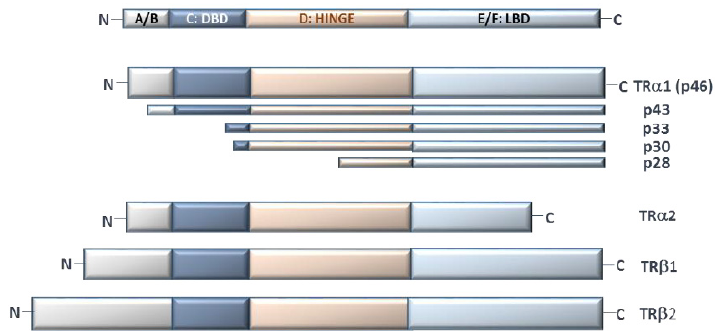
Figure 2. Schematic representation of the main TH isoforms. A/B: N-terminal domain, C: DNA binding domain (DBD), D: hinge region, E/F: ligand binding domain (LBD). binding domain (DBD), D: hinge region, E/F: ligand binding domain